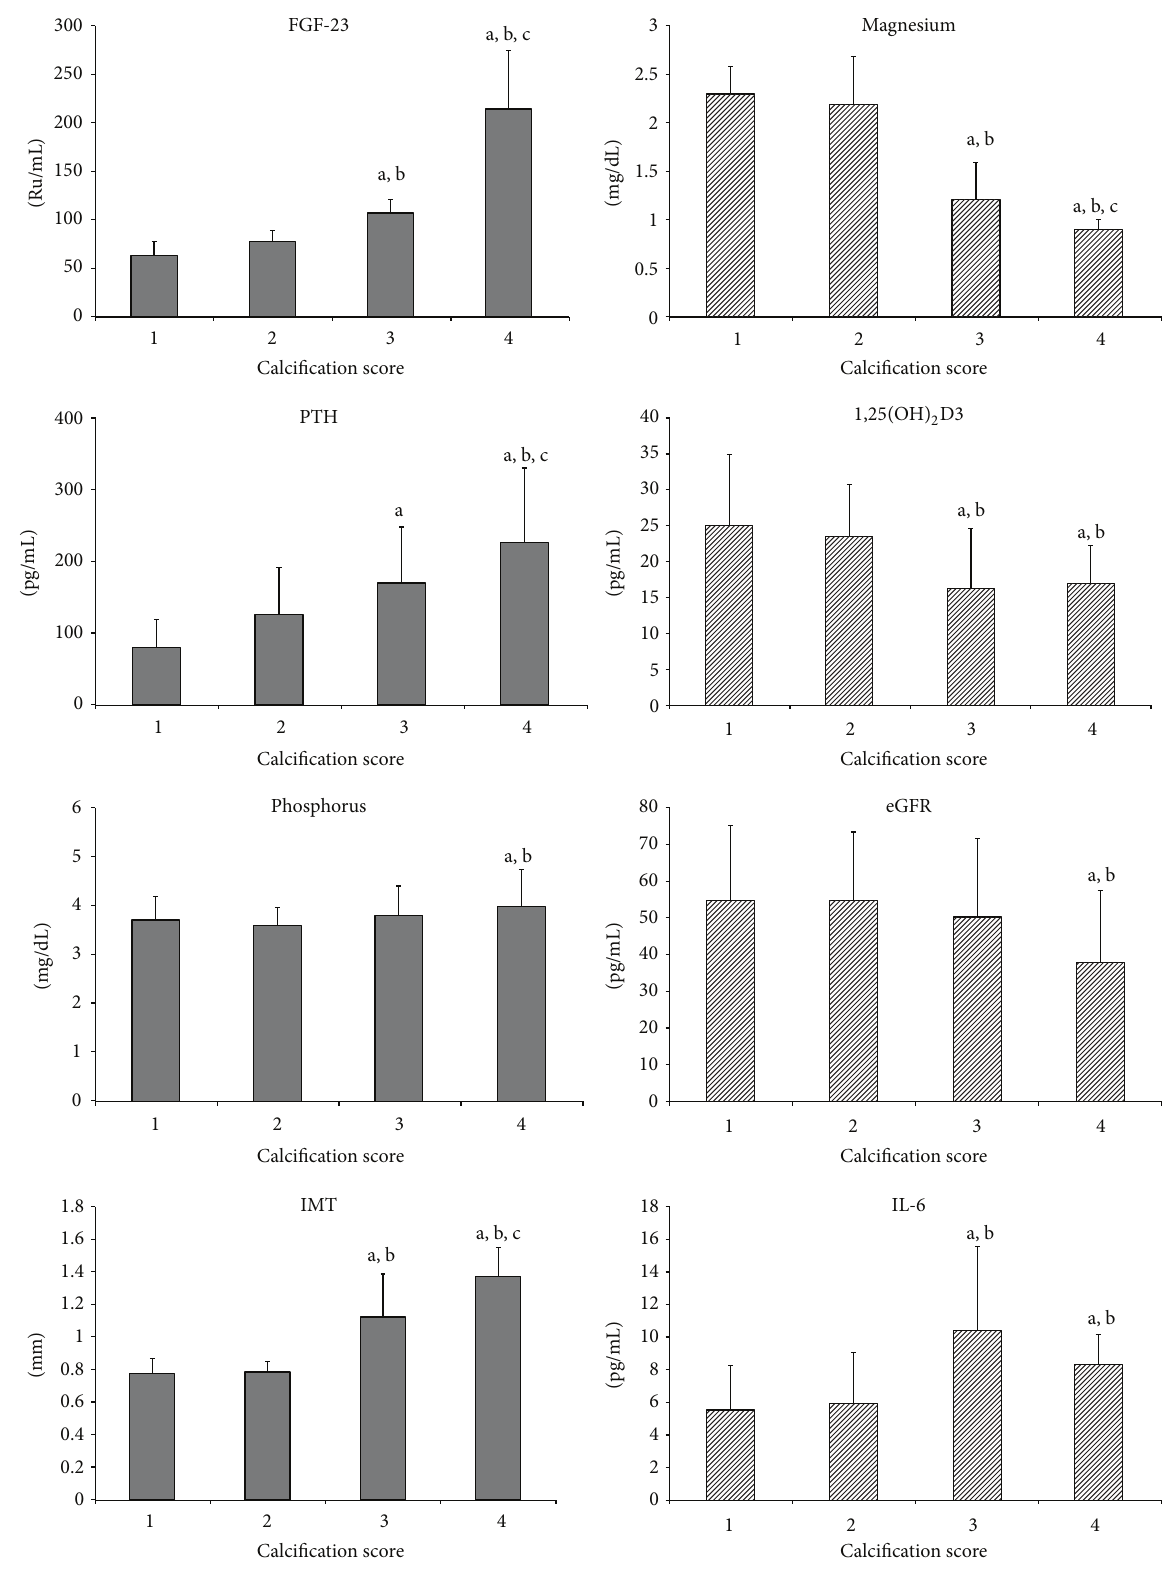
Figure 2: Parameters according to calcification score, 1 ( 𝑛 = 38 ), 2 ( 𝑛 = 47 ), 3 ( 𝑛 = 29 ), and 4 ( 𝑛 = 36 ). Results of post hoc analysis: a— 𝑃 < 0.05 versus Group 1, b— 𝑃 < 0.05 versus Group 2, and c— 𝑃 < 0.05 versus Group